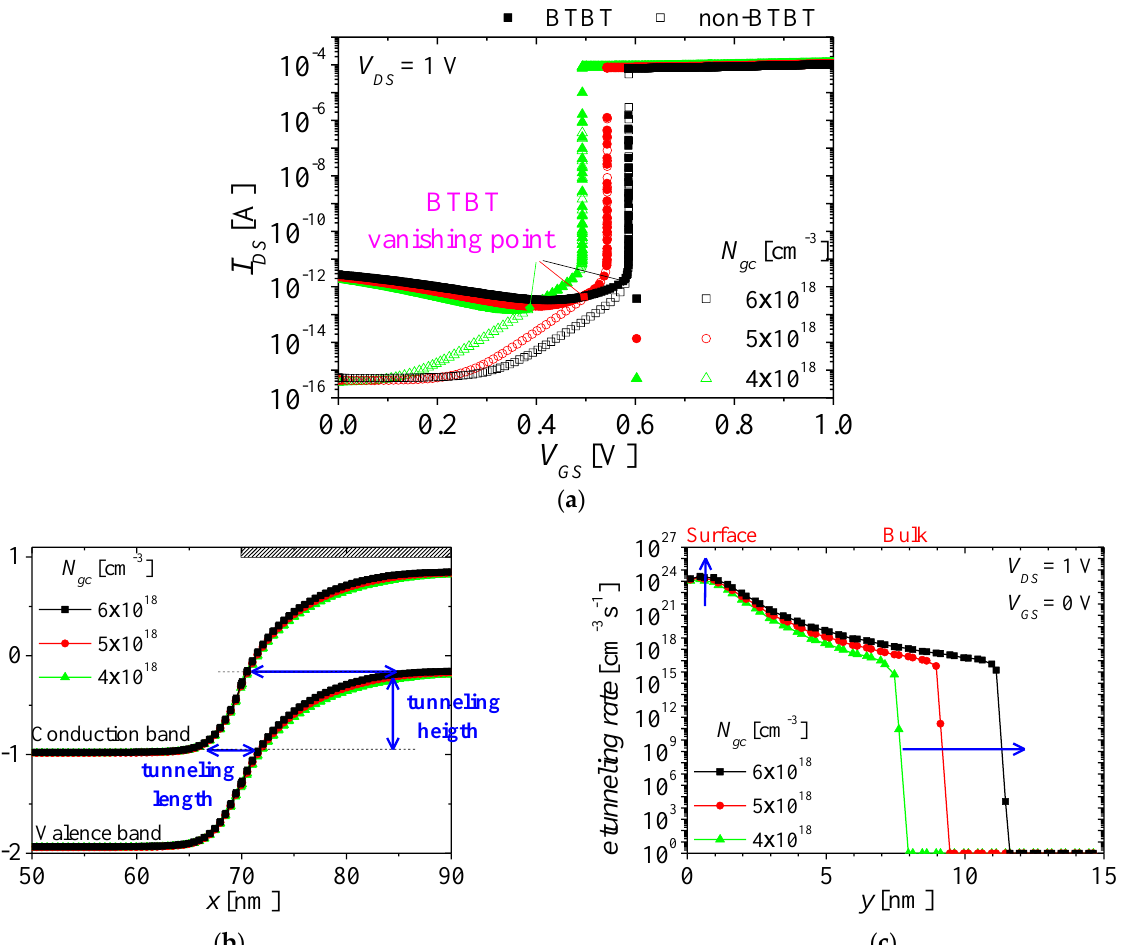
Figure 10. ( a ) Comparison of I DS - V GS characteristics of the NFBFET with N gc from 4 × 10 18 to 6 × 10 18 between considering and ignoring the BTBT, ( b ) the energy band on the surface region for ignoring the BTBT near N − P junction in the channel region with N gc from 4 × 10 18 to 6 × 10 18 at V DS = 1 V and V GS = 0 V, and ( c ) the tunneling rates from surface to bulk region of the NFBFET with N gc from 4 × 10 18 to 6 × 10 18 at V DS = 1 V and V GS = 0 V.